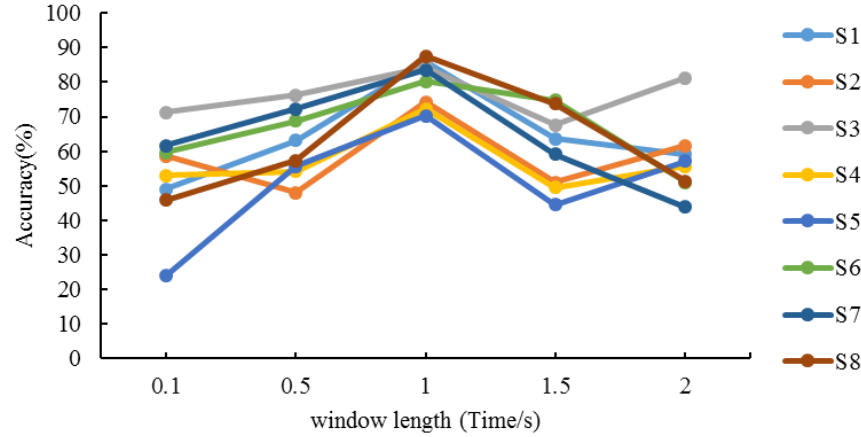
Figure 10. Recognition accuracy of different window lengths.